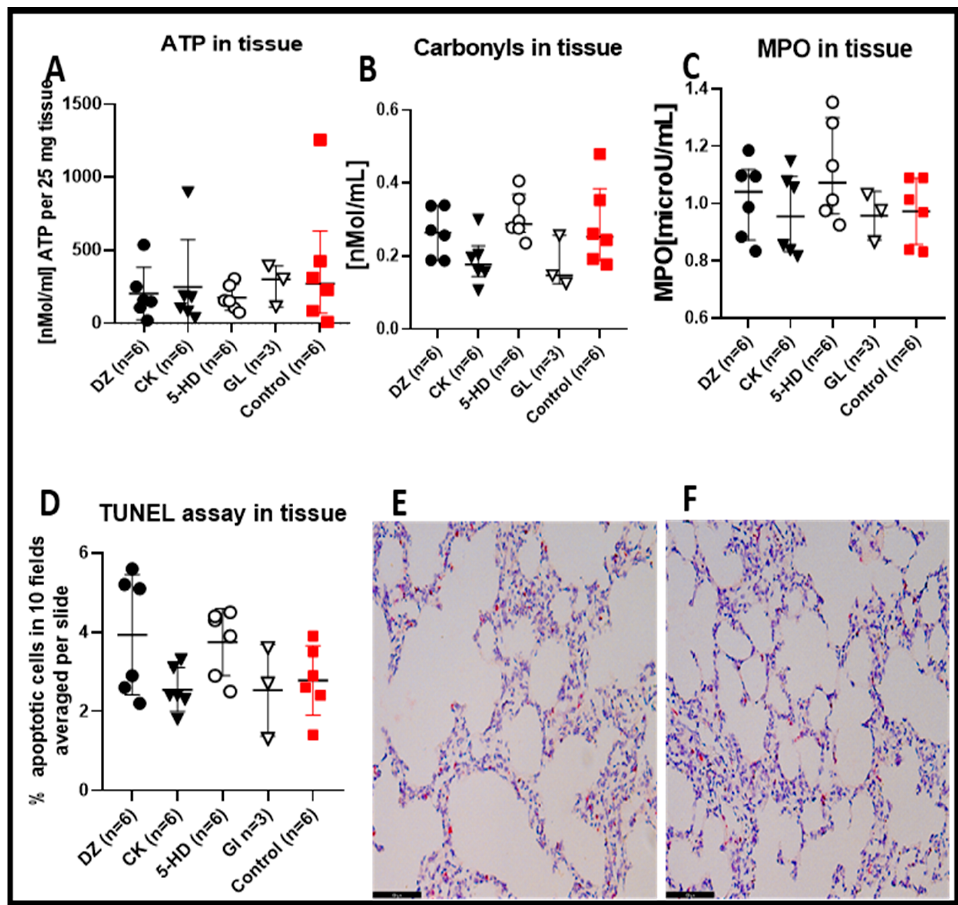
Figure 3. Tissue biochemical measurement. ( A ) There were no statistical differences in tissue ATP content in the perfused lungs after 4 h EVLP between the control and the 4 types of K(ATP) channels modulators. ( B ) The carbonyl proteins detected in the lung exposed to CK and GL K(ATP) channel modulators were lower, although not significantly when compared to the control. ( C ) The MPO in the lung exposed to DZ and 5-HD K(ATP) channel modulators did not have statistically significantly higher values versus the control. ( D ) TUNEL-positive cells detected in the lung tissues exposed to the different K(ATP) channel modulators were not significantly different compared to control. Representative TUNEL-stained sections for assessment of lung apoptotic cells in the DZ group ( E ) and the control group ( F ). Sections are shown at × 200 magnification at the end of 4 h EVLP. The scale bar indicates 100 µ m